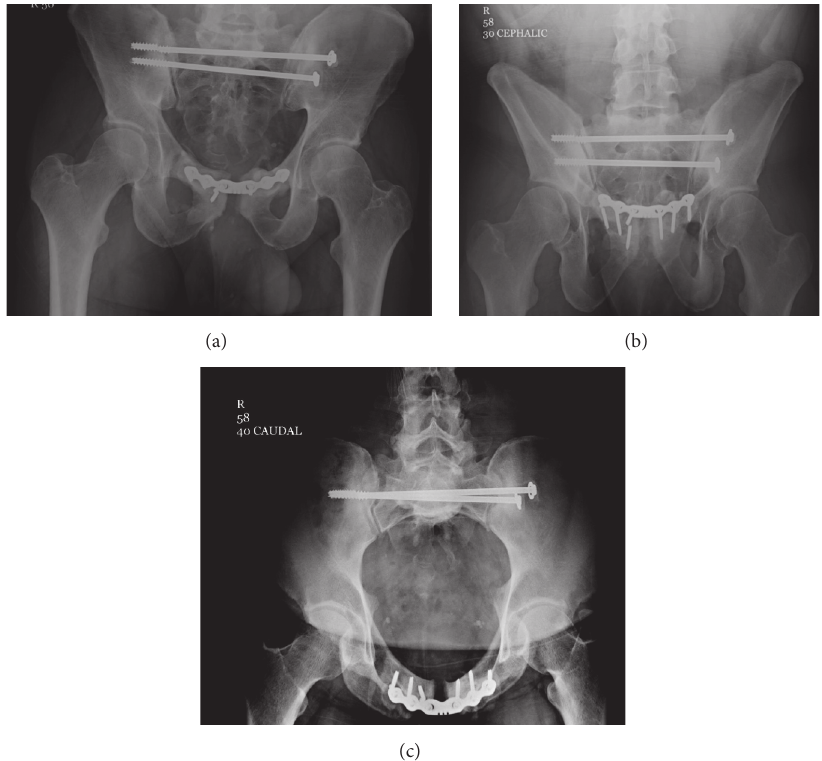
Figure 4: (a) Pelvis AP, (b) outlet, and (c) inlet views at two-year